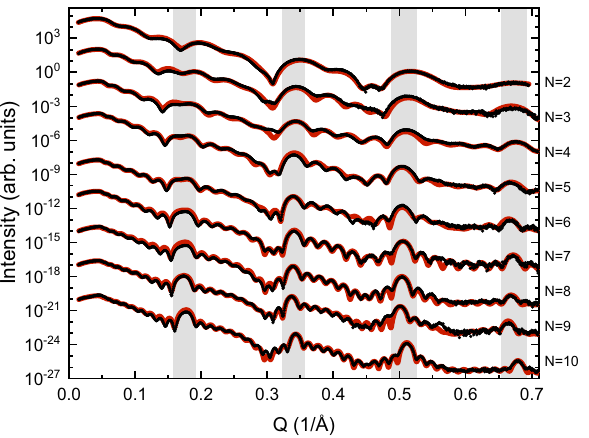
Figure 1. X-ray reflectivity measurements (black dots) and GenX fits (red lines) of [Fe/MgO] N multilayers. The data is shifted (in intensity) for clarity and the peak positions corresponding to the repeat distance (cid:31) of the samples, are indicated by light grey